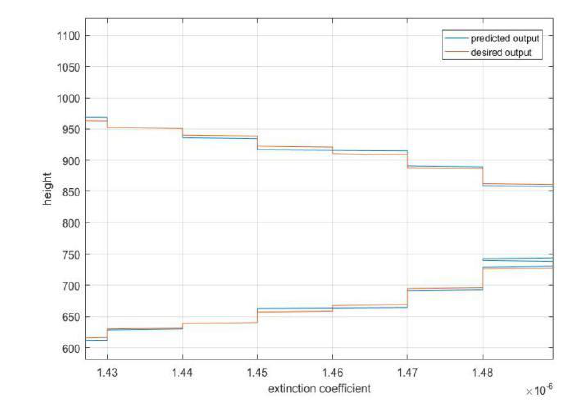
Figure 9. Partial enlargement under cloudless conditions The training effect is still excellent with a relative error of 0.2% under cloudless conditions. The extinction coefficient obtained through GA-BP neural network model is very consistent with that obtained by Klett